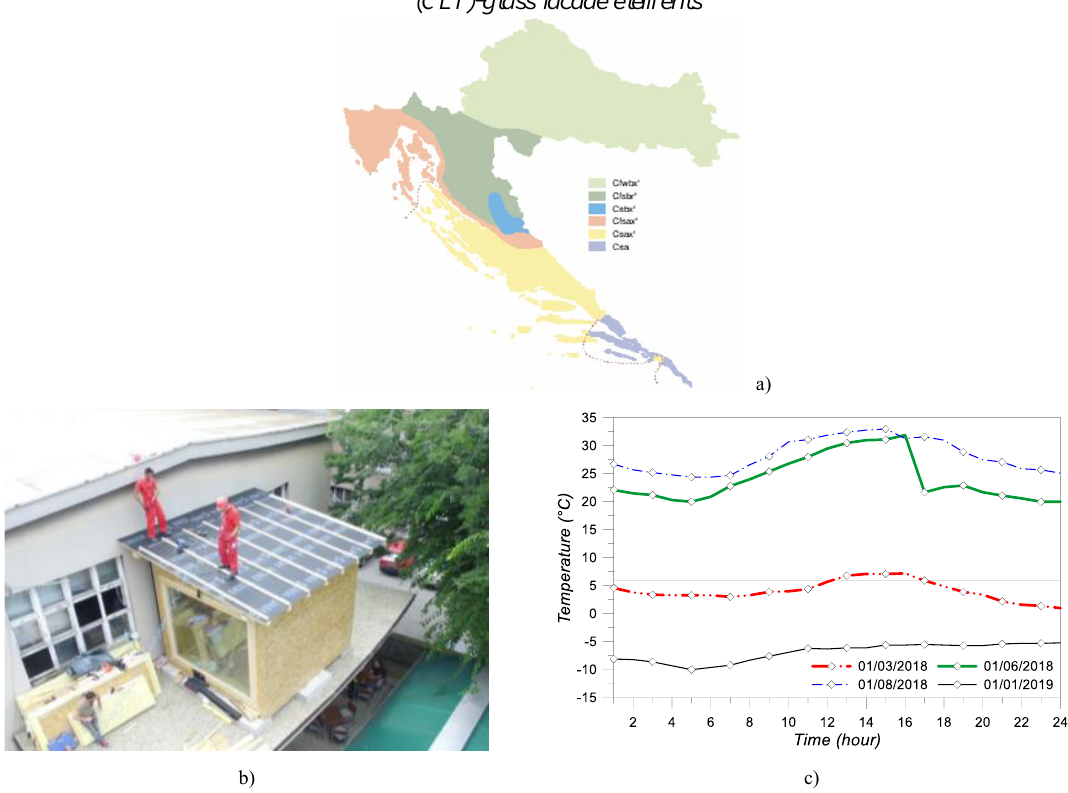
Fig. 2 Ambient measurements: a) Köppen’s classification of Croatian climate (reproduced from (Zanor et al., 2005)), with b) Live Lab installation and c) example of outdoor temperatures (selection).